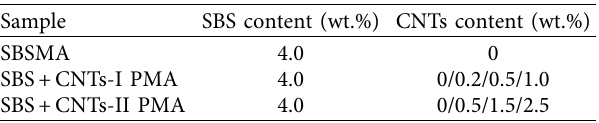
Table 3: Samples used in the